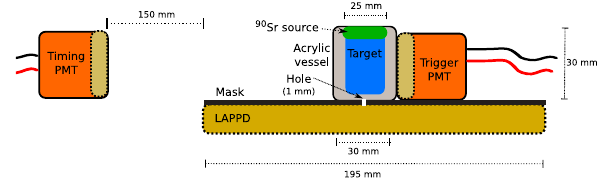
Fig. 3 Theexperimentalsetupusedforthemeasurementsinthispaper. A 90 Sr β − source is deployed above a liquid target contained in a cylin- drical UVT acrylic vessel, above an LAPPD which is used to detect single photons, which are mostly blocked by a black mask. A